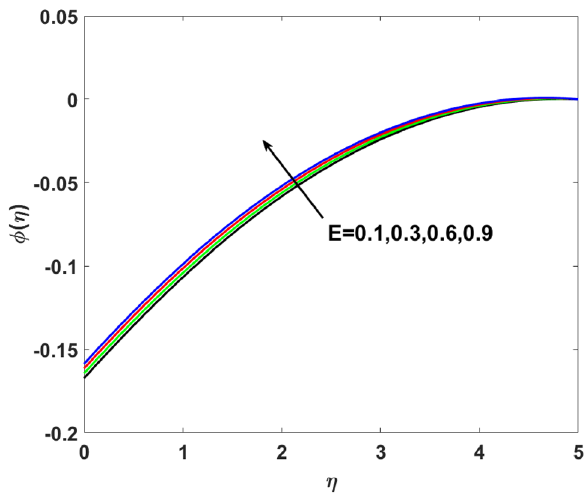
Figure 14. φ(η) versus E .